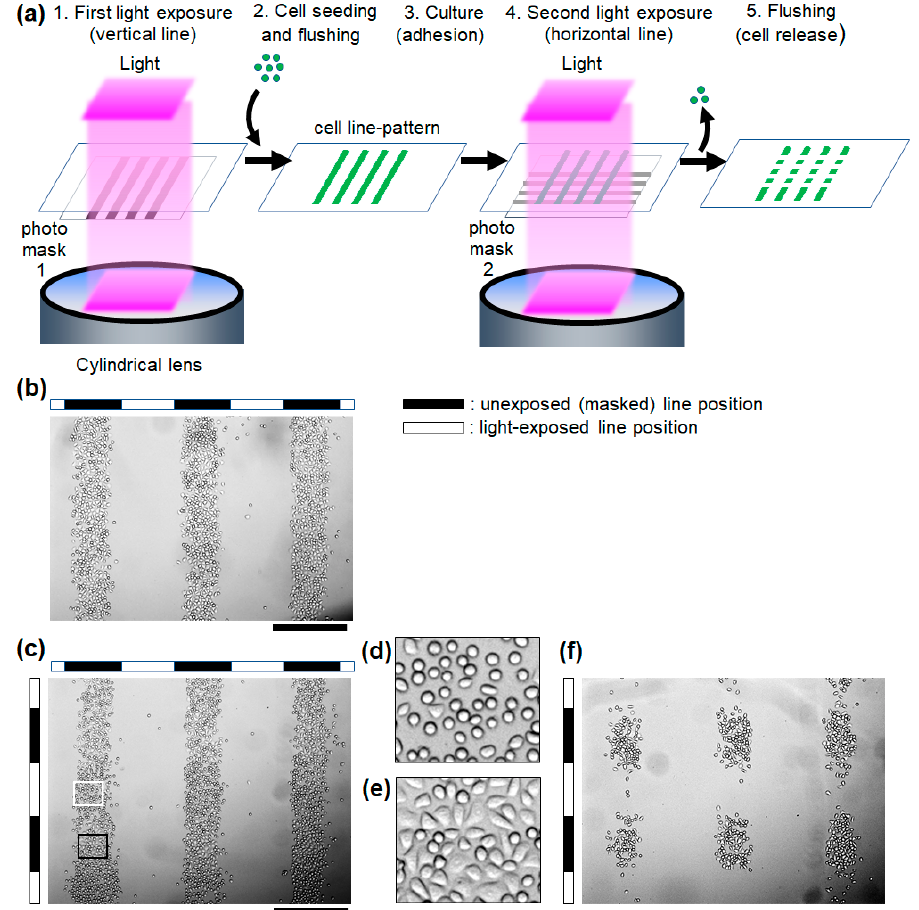
Figure 4. Light-guided micropatterning and release of adherent cells on the photocleavable RGD-PEG surface. ( a ) Schematic illustration of the cell patterning and release. ( b ) The microscopic image of the vertical line-pattern of HeLa cells after cell adhesion to the first exposed surface. ( c ) Cells immediately after the second exposure of the horizontal line-pattern of light. Scale bars: 500 μ m. Magnified image of the cells in the ( d ) light-exposed (white square in ( c )) and ( e ) unexposed regions on the horizontal line-pattern of the second exposure (black square in ( c )). Scale bars: 50 μ m. ( f ) The remaining cell pattern after the second light exposure and rinsing. Scale bars: 500 μ m.